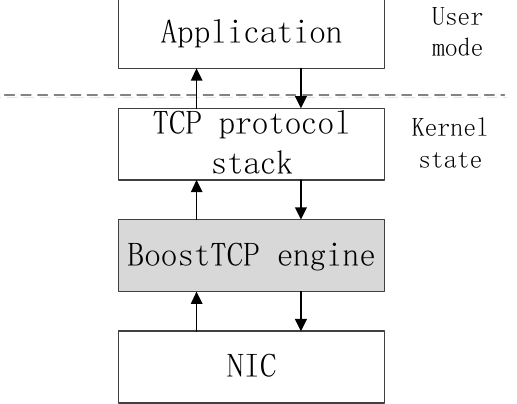
Figure 3. Illustration of the BoostTCP position in the multi-layer network transmission architecture.